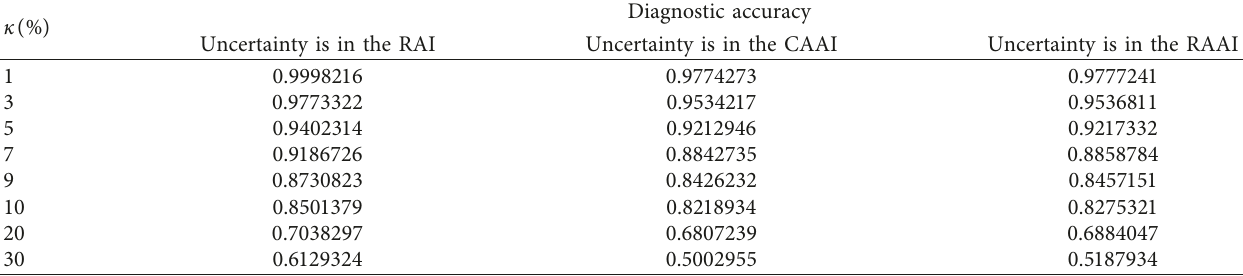
Table 2: Diagnostic accuracy of the proposed method of IEEE 14-bus system for different κ